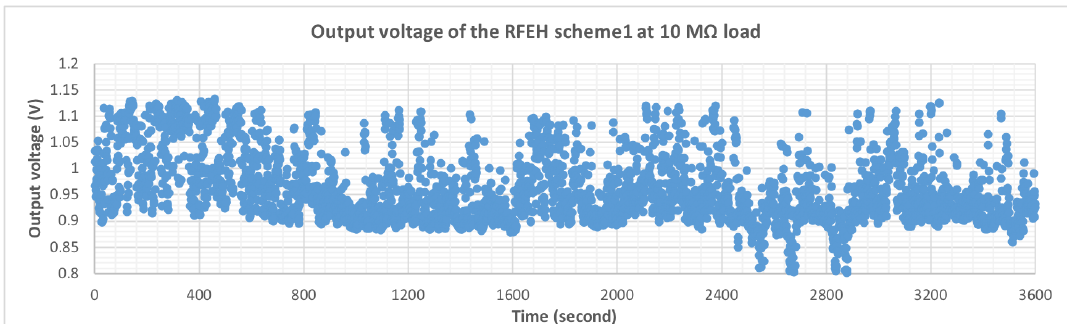
Figure 23. Output voltage of scheme 1 at 10 M Ω loads as measured for 1